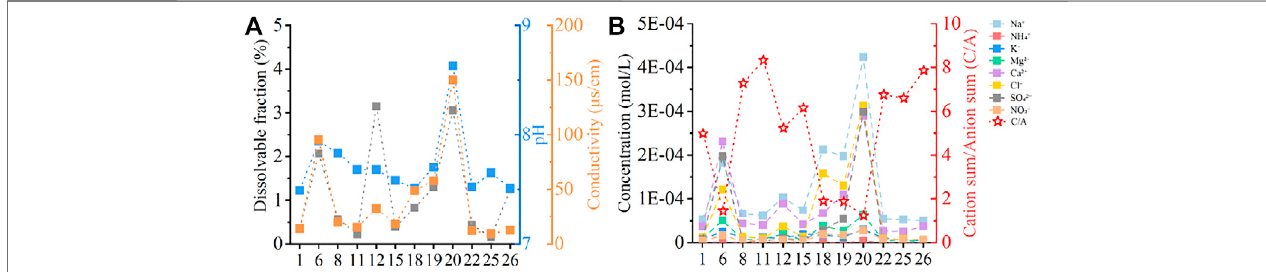
FIGURE4| (A) The dissolvable fractions, pH and conductivitiesofthe12 sample solutions. (B) On theleft vertical axis the ionic molar concentrationsmeasured by ICareshown,whiletherighthandaxisscalingdepictstheratiooftotalcationicchargestototalanioniccharges(C/A).Theamountofeachcationoranion( n )ismultiplied by the number of charges and then added together to get the total charges of the cation or anion, i.e., cation sum = n (Na + ) + n (NH 4+ ) + n (K + ) + 2 n (Mg 2+ ) + 2 n (Ca 2+ ); anion sum = n (Cl − ) + 2 n (SO 42 − ) + n (NO 3 − ).